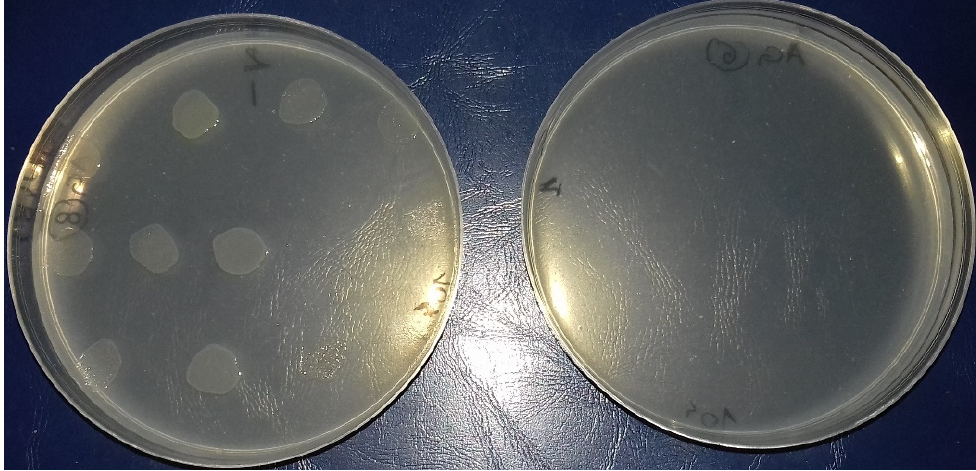
Figure 3. Salmonella strains. Left side: growth/no growth of the strains. Right side: total inhibition of growth in presence of 1% garlic used as inhibition control.